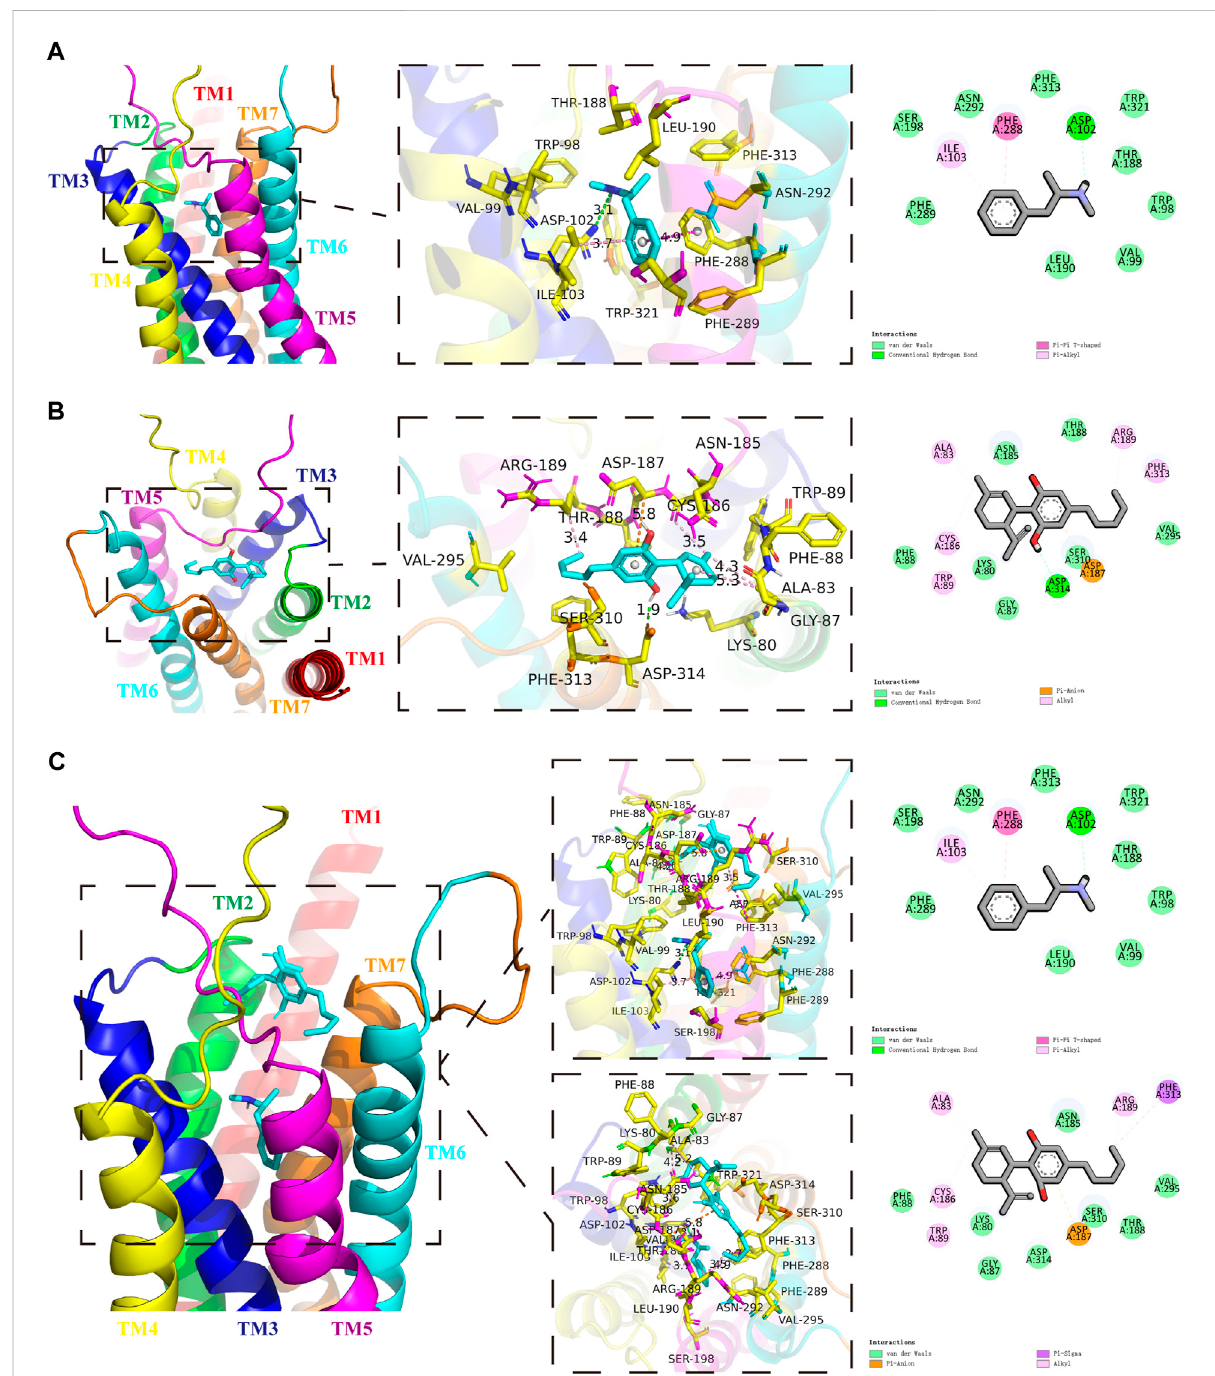
FIGURE 1 Protein-drugbindingsimulations.SeventransmembranedomainsofDRD1areshownasmulticolorbands.METHorCBDaremarkedincyan,while key DRD1 residues are marked in yellow. (A) Docking pose, binding sites, and interactions between DRD1 model and METH. (B) Docking pose, binding sites, and interactions between DRD1 model and CBD. (C) Docking pose, binding sites, and interactions among CBD, METH, and DRD1